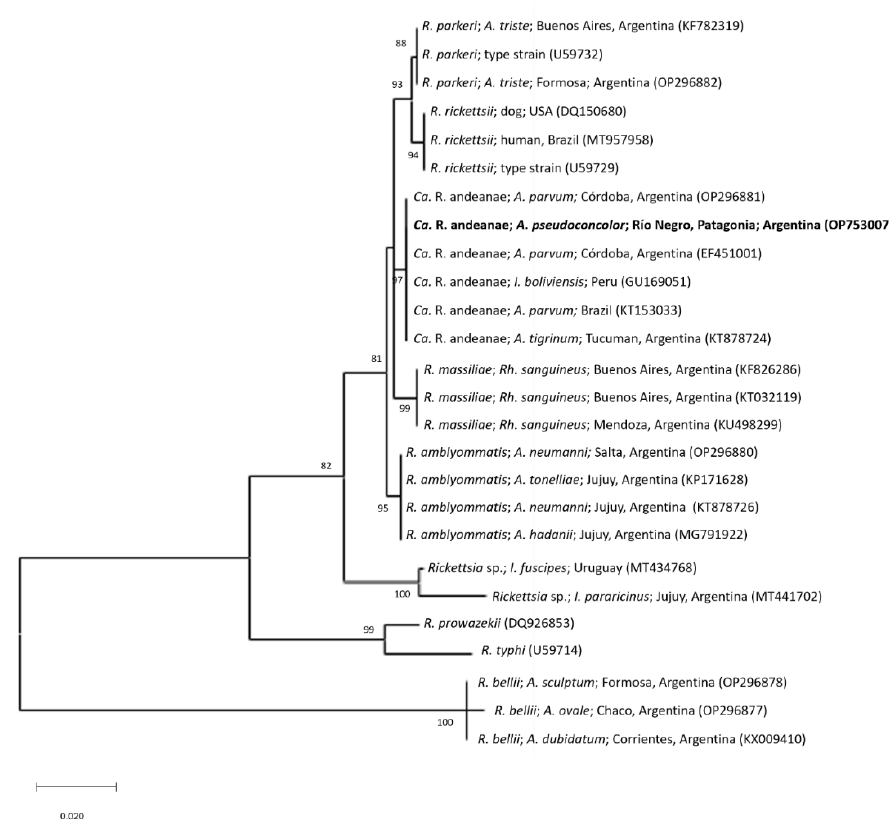
Figure 2. Maximum-likelihood tree constructed from gltA partial sequences of different Rickettsia species (Substitution model: Tamura-Nei 93 model with Gamma distribution). The sequence gener- ated in this study is written in bold letters. Numbers represent bootstrap support generated from 1000 replications. GenBank accession numbers are given in brackets. Abbreviations: A .: Amblyomma ;